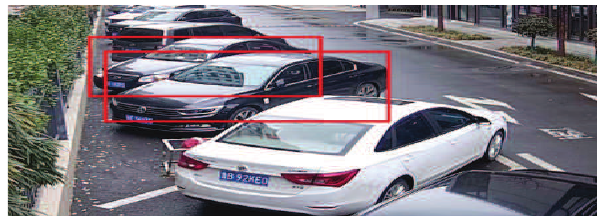
Figure 9. Vehicle